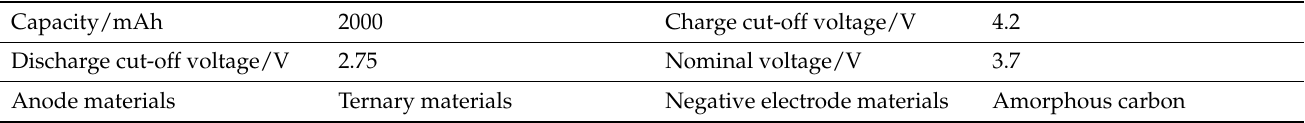
Table 2. Main parameters of 18650